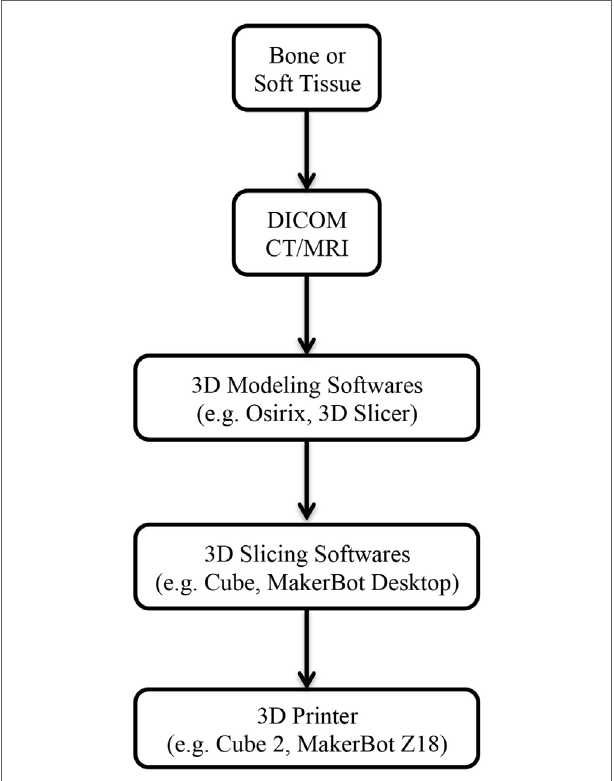
FiGURe 1 | Steps involved from imaging to 3D-printed models . Abbreviations: DICOM, digital imaging and communications in medicine; CT, computed tomography; MRI, magnetic resonance